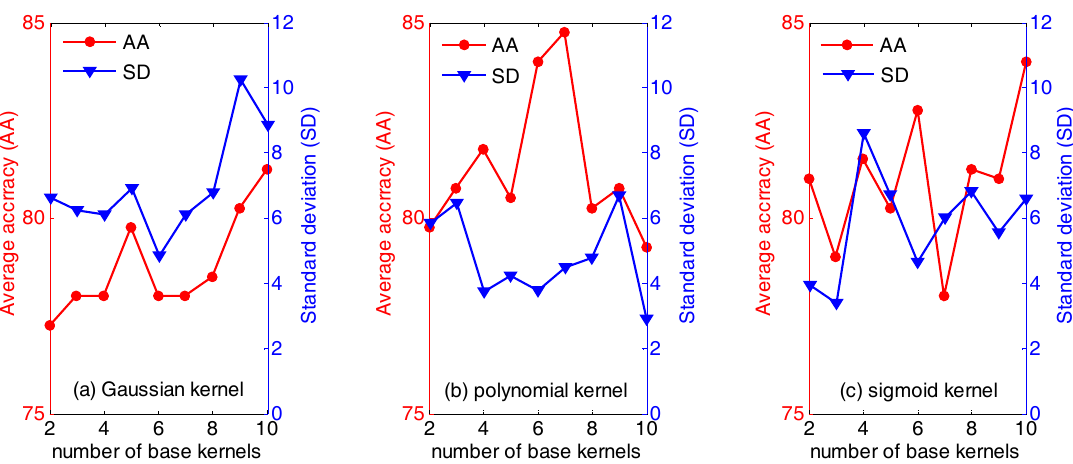
Figure 3. The performance of weighted kernels Fisher discriminant analysis combined with quantum-behaved particle swarm optimization (QWKFDA) using different kernels with the number of base kernels from 2 to 10. Table 1. Confusion matrix of the best classification results of QWKFDA for three types of base kernels.